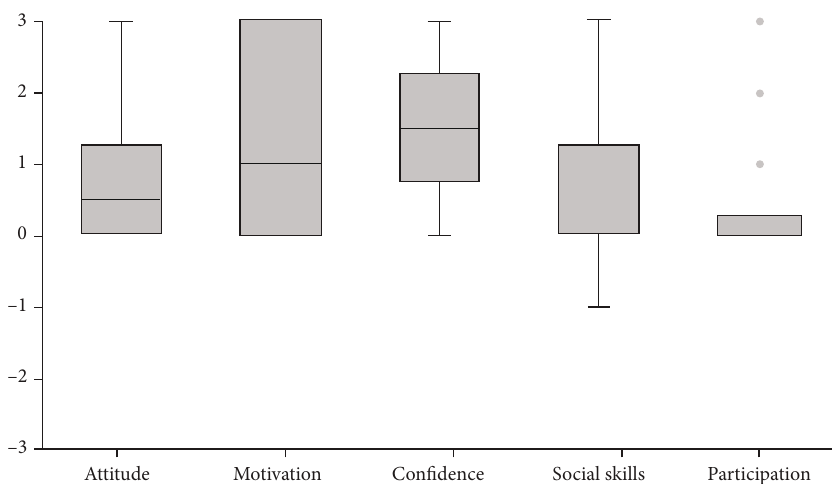
Figure 5: Median changes parents reported on a scale of -3 (became much worse) to +3 (became much better). The boxplots show the median, the fi rst and third quartile, the range, and the